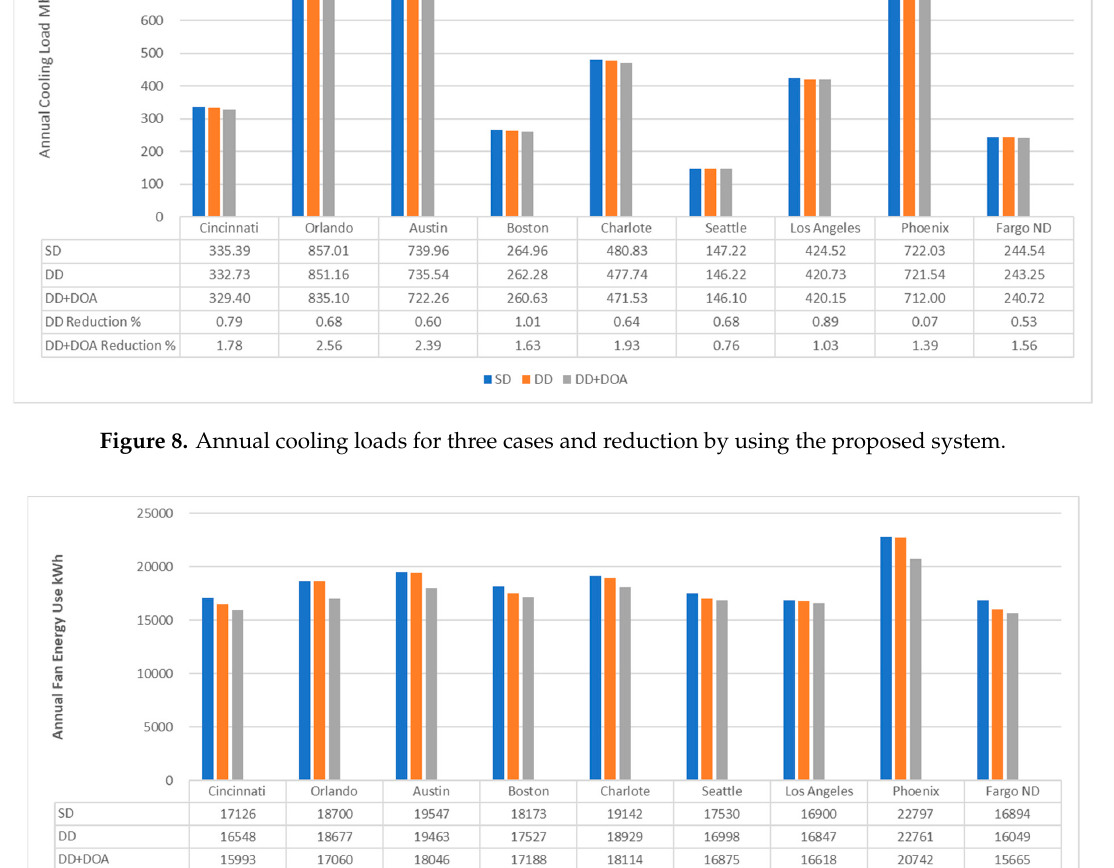
Figure 7. Annual heating loads for three cases and reduction by using the proposed system.